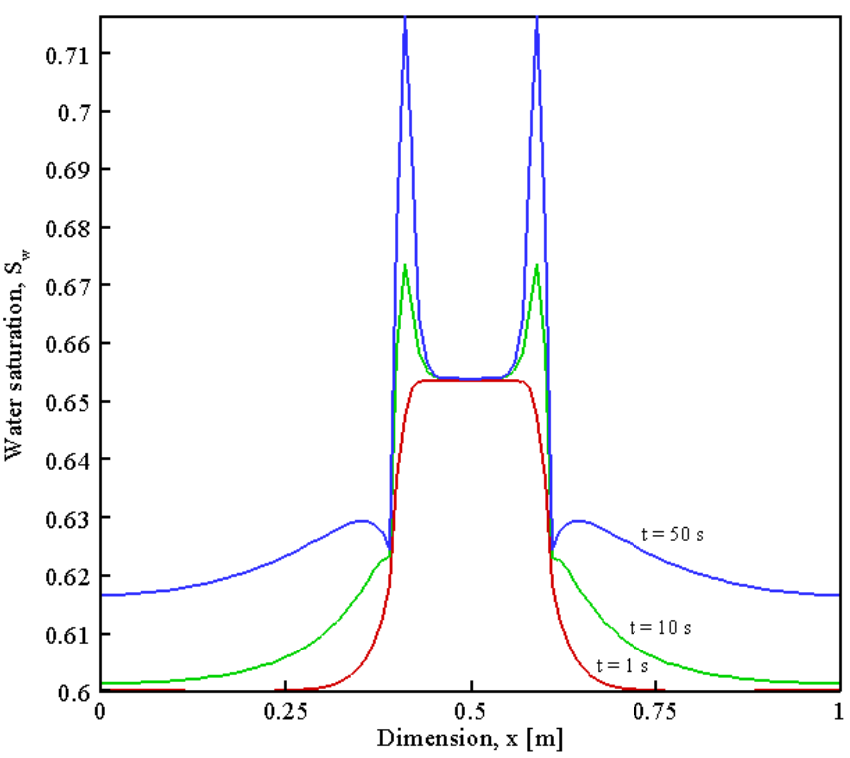
x at the different moments of